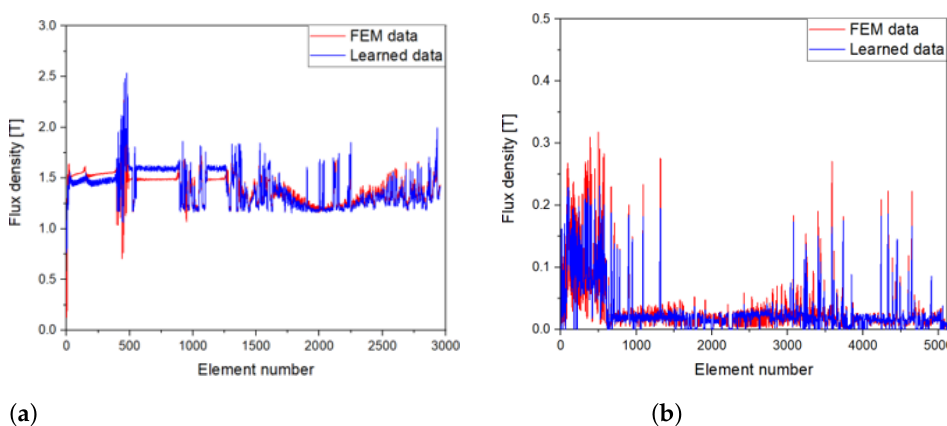
Figure 12. Comparison of harmonics by FEM and learning model: ( a ) stator. ( b )